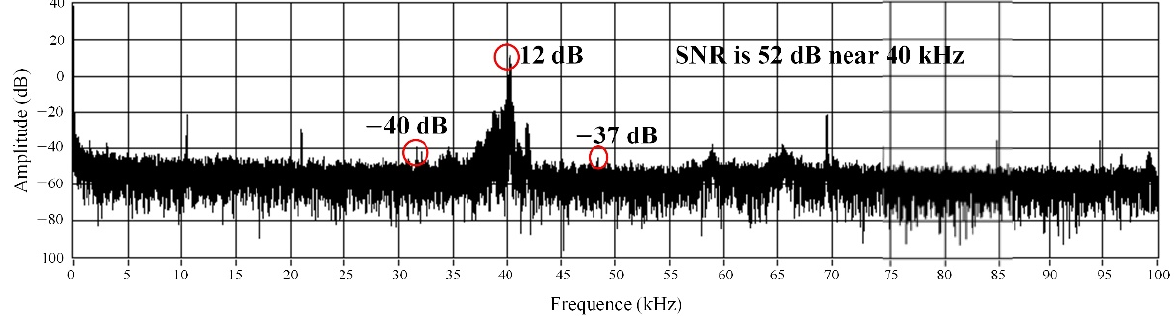
Figure 9. Frequency-domain signal of the sensor.